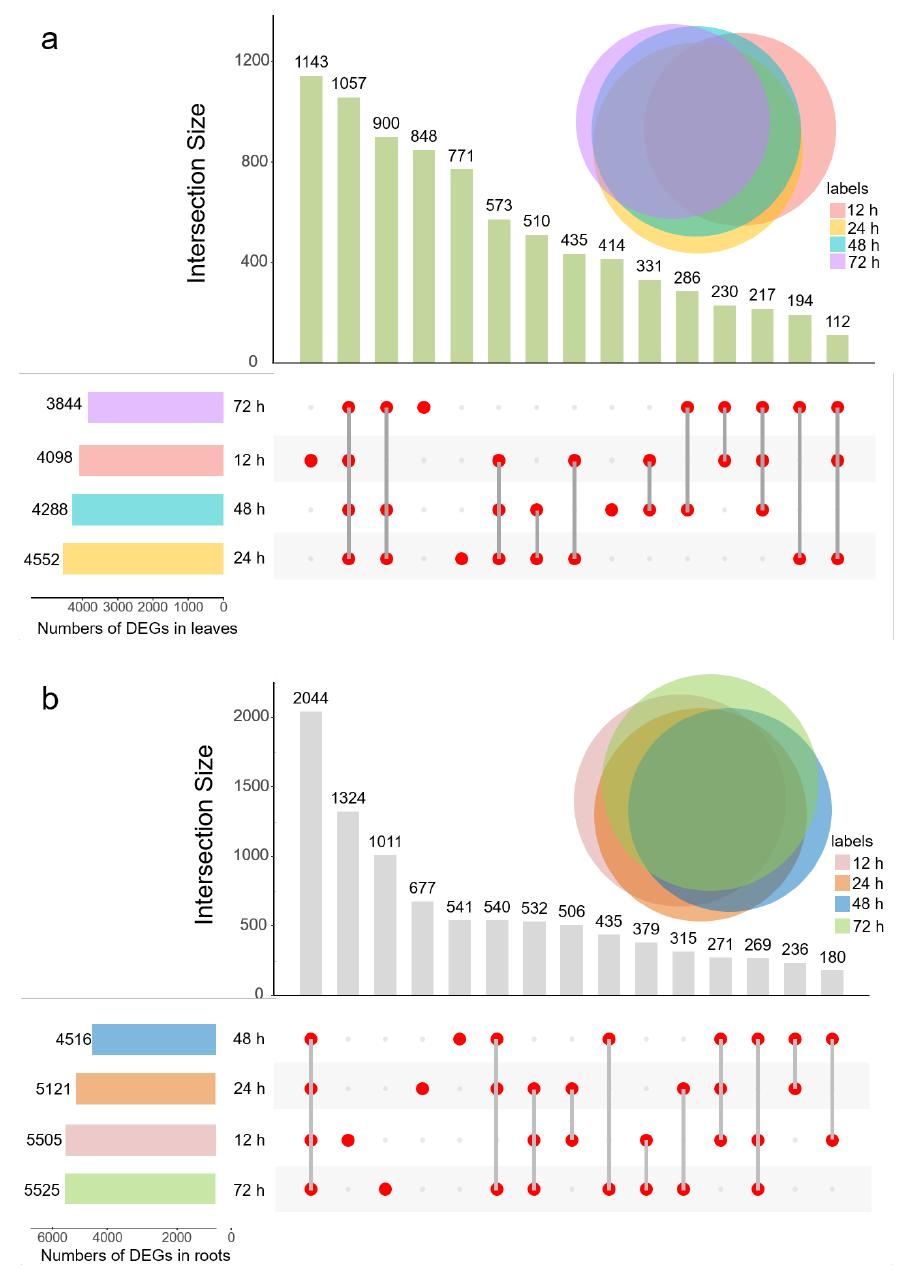
Figure 3. Distribution of DEGs among samples treated with salt for different durations. ( a ) leaves ( b ) roots. 2.4. Co-Expression Network Analysis of Differentially Expressed